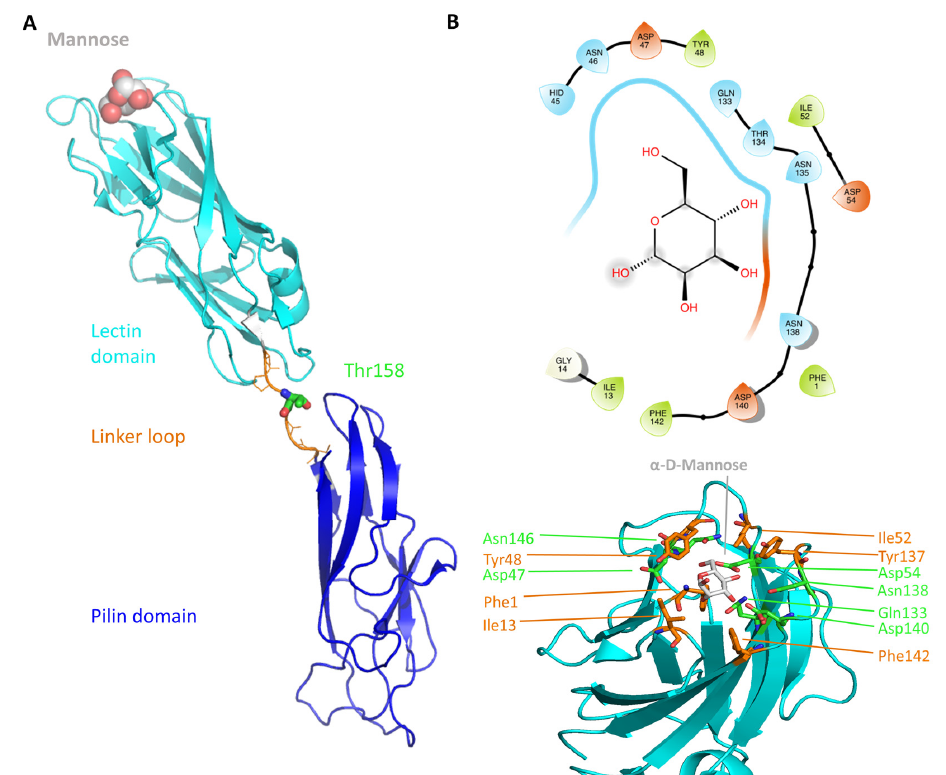
Figure 1. The FimH structure and organization ( A ) An elongated linker (orange) connects the pilin (blue) and the lectin (cyan) domain of FimH (PDB code 1KLF [14]). The protein is shown in cartoon and the bound α - D -mannose molecule is depicted as atom-colored (grey for carbon) van-der-Waals spheres. Additionally, the position of T158 is shown as atom-colored sticks (green for carbon). ( B ) The mannose-binding site of the FimH lectin domain. On the top the 2D diagram of the binding site is depicted (prepared with Maestro using a cutoff of 5 Å) and on the bottom the 3D representation of the same site. The mannose molecule is highlighted in gray. The polar (green) binding site residues as well as the hydrophobic rim residues (orange) are additionally depicted. The 3D protein representations in this and the following figures were prepared using Pymol [29].